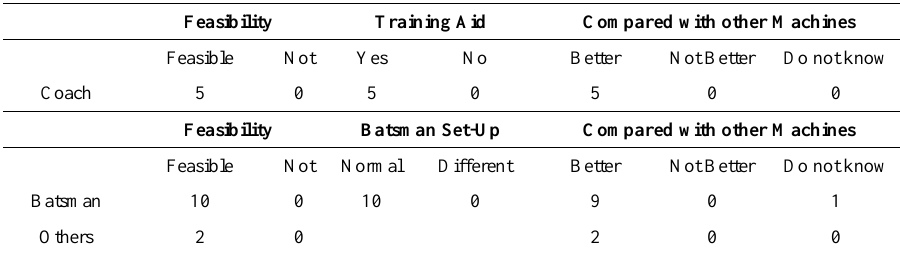
Table 4. Results of the survey conducted [32]